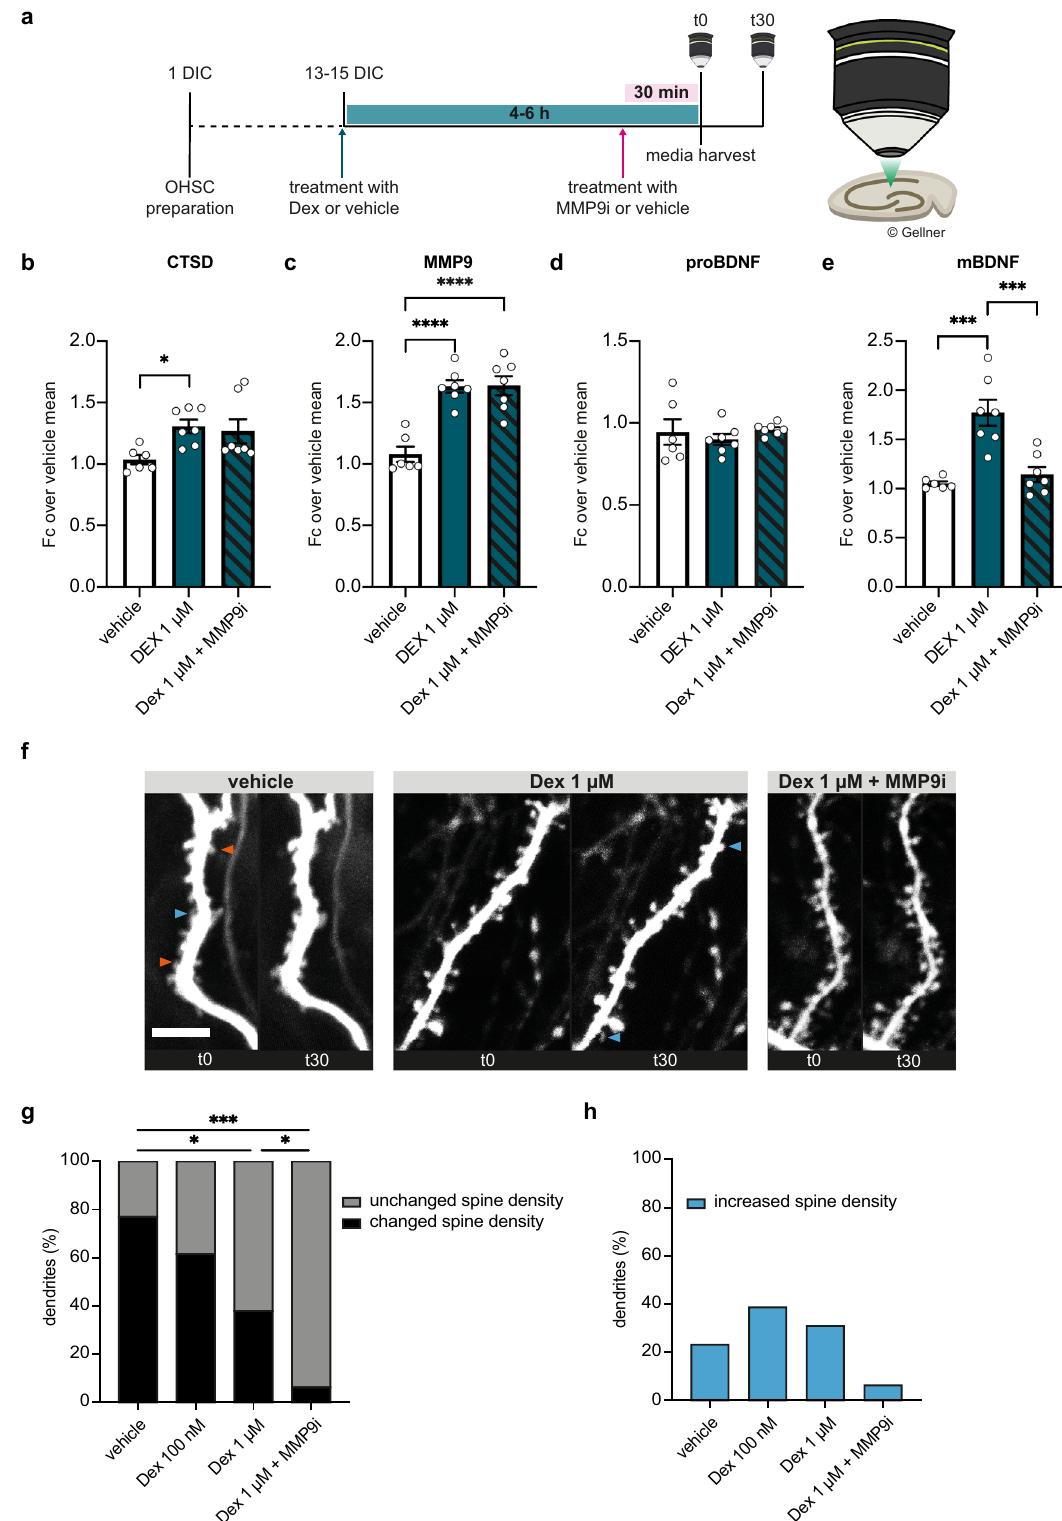
enhanced secretion of CTSD upon dexamethasone treatment. Taken together, these results con fi rm that GC-mediated stress enhances secretory autophagy via FKBP51. The analysis of the GC-induced secretome revealed that a surprisingly high proportion of secreted proteins (63%) show an autophagy-dependent release as indicated by a higher level